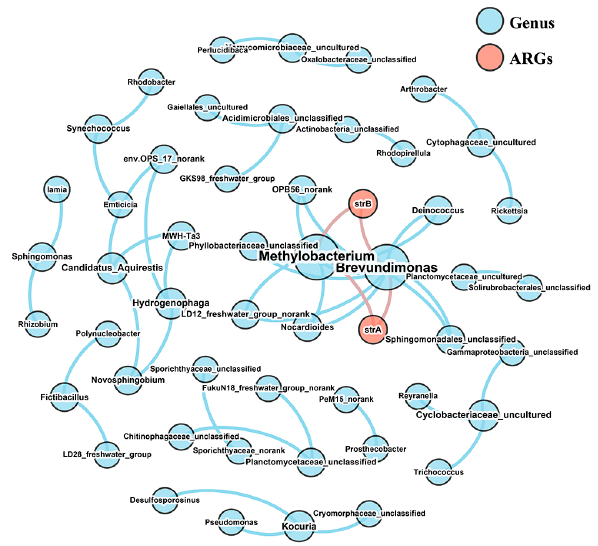
Figure 5. Network analysis revealing the co-occurrence patterns among ARG subtypes and bacteria genera. Nodes are colored according to ARG subtypes. Connection represents correlation. Size of each node is proportional to the number of connections.